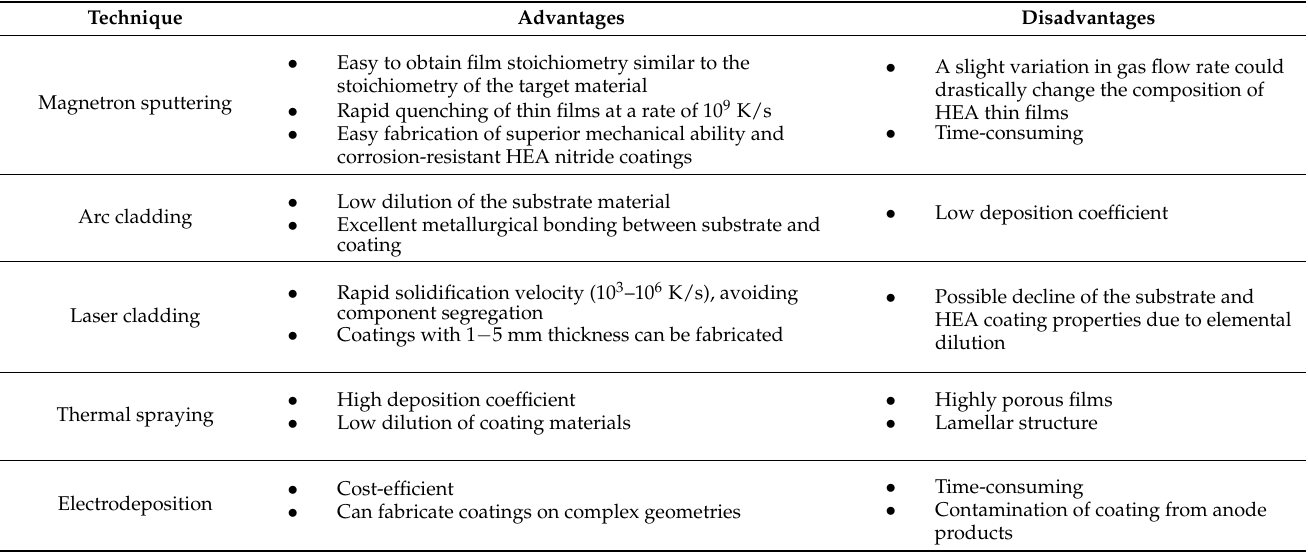
Table 1. Summary of HEA-based coating techniques